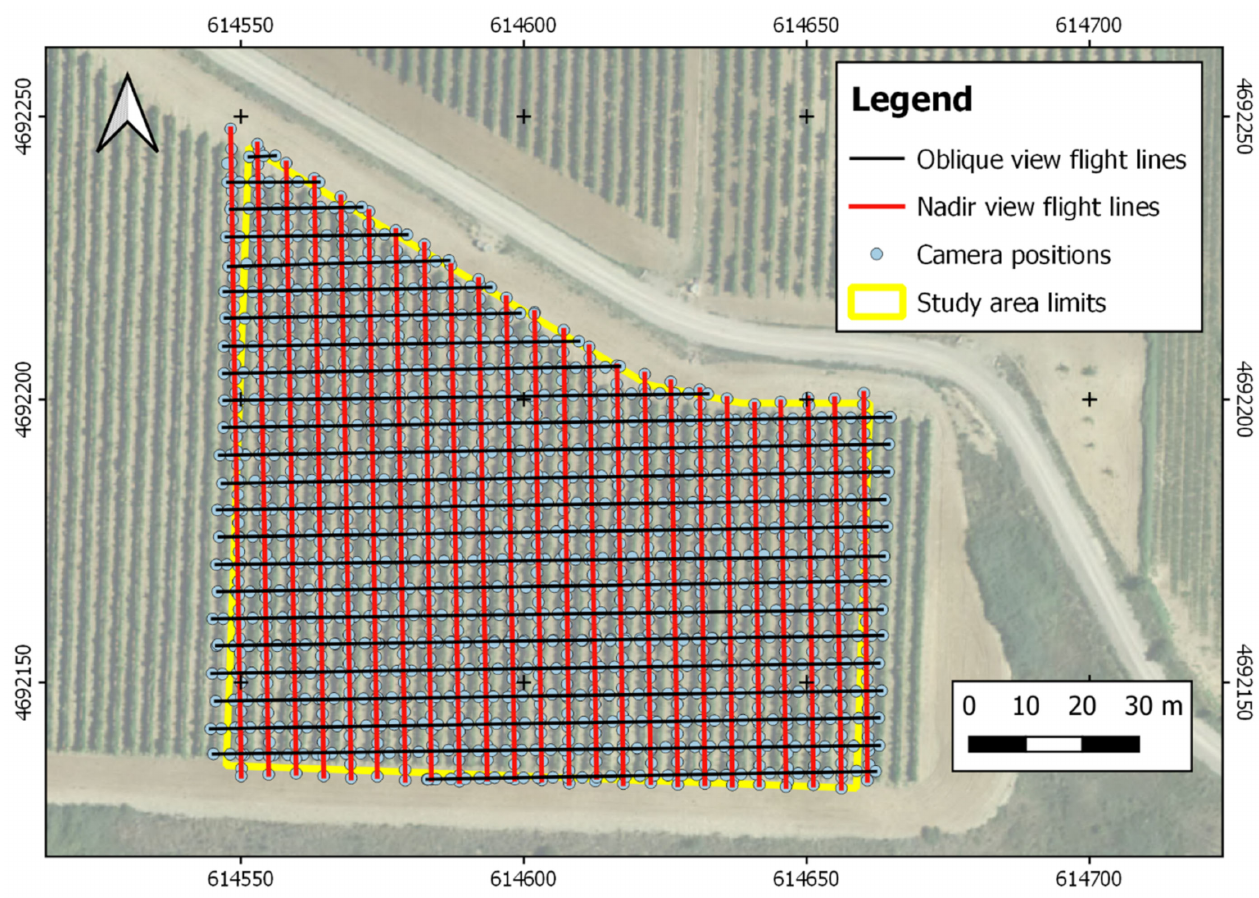
Figure 3. Map of the Garnacha field showing the coordinates of the image acquisition points and the UAV flight lines with the different sensor orientations. Coordinate system: WGS84